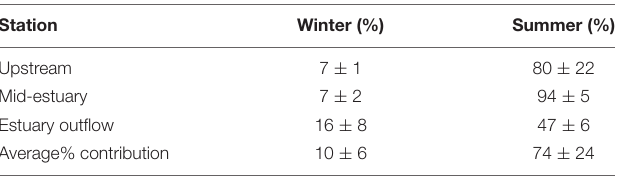
TABLE 2 | Summary of the percent (mean) contribution of aggregate-associated heterotrophic diazotrophs to total heterotrophic N 2 fixation (defined as 100%). Station Winter (%) Summer (%) Upstream Mid-estuary Estuary outflow 16 ± 8 47 ± 6 Average% contribution 10 ± 6 74 ± 24 The mean and standard deviation was calculated from three